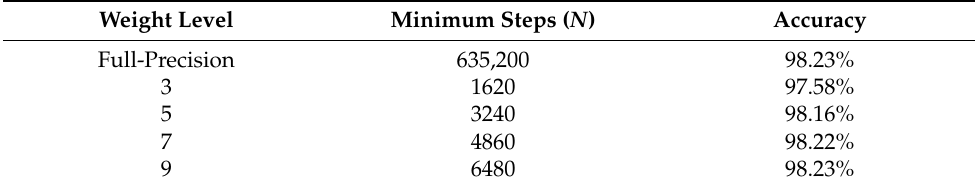
Figure 7. ( a ) Classification accuracy according to the simulation time when 3, 7, 5, and 9-level of the quantization weights transferred by the proposed method are used; ( b ) the variation effects on the classification accuracy with 3, 7, 5, and 9- level of the quantization weights.